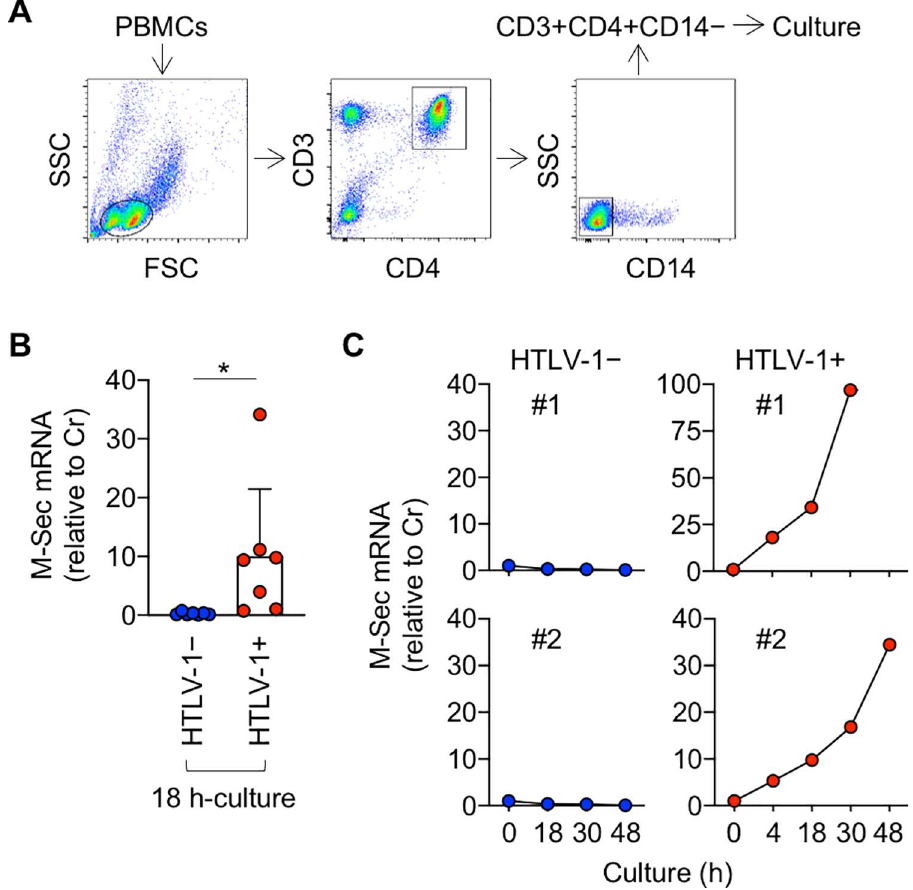
Fig 1. Expression of M-Sec in cultured CD4 + T cells of HTLV-1 carriers. ( A ) The CD3 + CD4 + CD14 - cells in the live cell gate were sorted from peripheral blood mononuclear cells (PBMCs). The profile of an HTLV-1 carrier is shown as an example. CD14 was used to exclude monocytes, which abundantly express M-Sec [3,8]. ( B ) The sorted CD3 + CD4 + CD14 - cells of HTLV-1 - individuals (HTLV-1 − ; n = 7) or HTLV-1 carriers (HTLV-1+; n = 7) were analyzed for the expression of M-Sec mRNA by using qRT-PCR, before or after culturing for 18 h. The expression levels are shown by setting the value of un-cultured cells as 1. � p < 0.05. ( C ) The sorted CD3 + CD4 + CD14 - cells of HTLV-1 - individuals (HTLV-1 − ; #1 and #2) or HTLV-1 carriers (HTLV-1+; #1 and #2) were cultured for the indicated periods and analyzed as in ( B ). The expression levels are shown by setting the value of un-cultured cells as